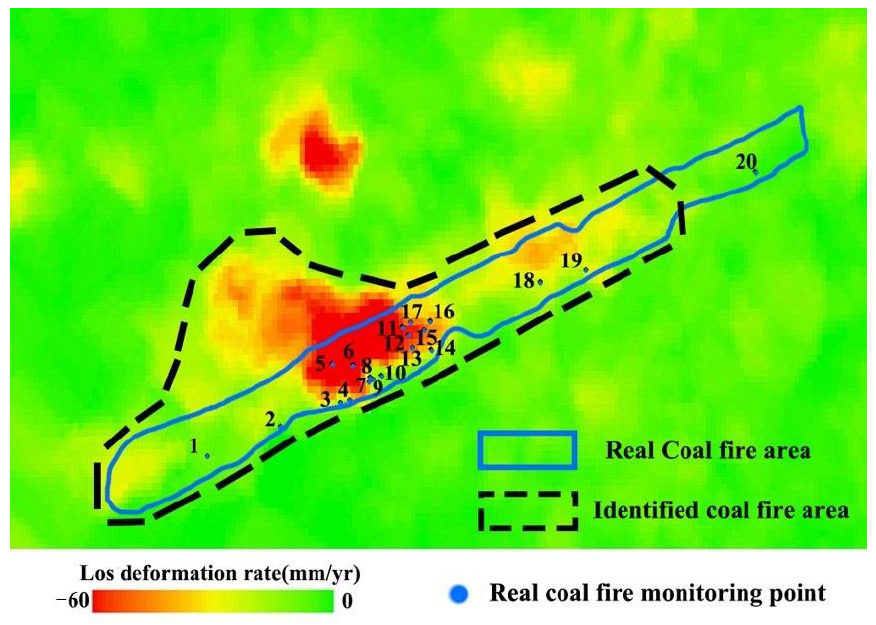
Figure 14. Distribution of in-situ coal fire points and interpolation result of the subsidence rate in the study area.